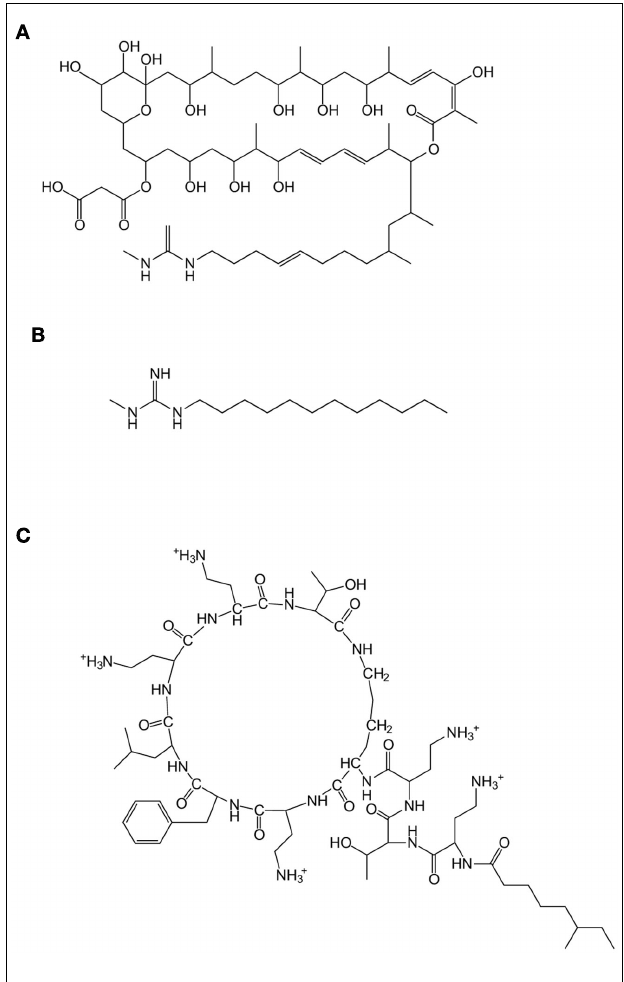
FIGURE 3 | Structures of niphimycin (NM) (A), N -methyl- N (cid:3)(cid:3) - dodecylguanidine (MC12) (B), and polymyxin B (PMB)